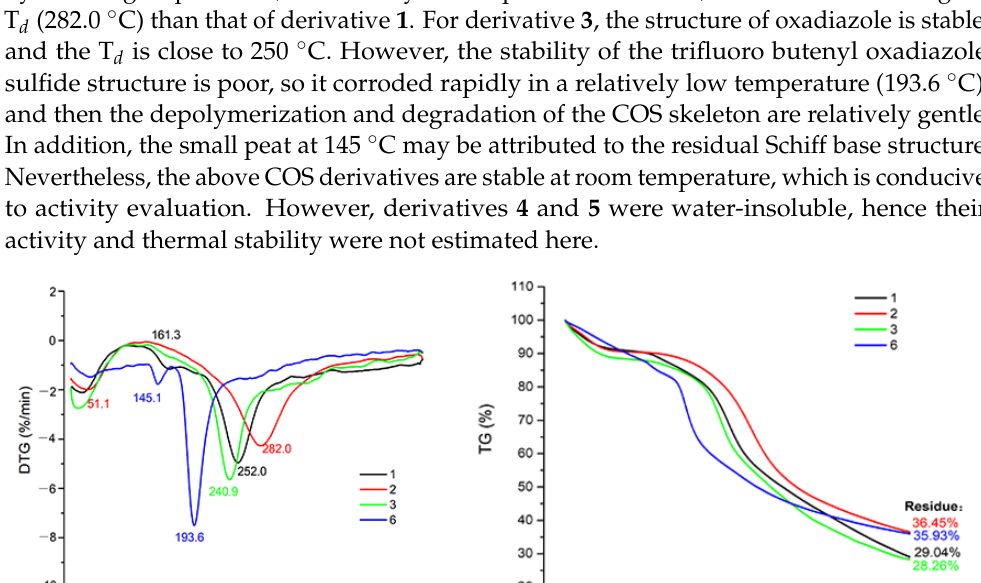
Figure 2. 1 H NMR, 19 F NMR, and 13 C NMR spectra of fluoroalkenyl COS derivative.